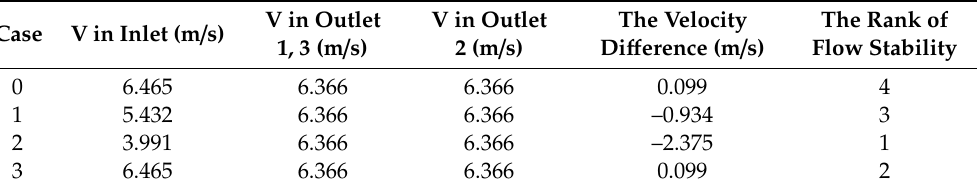
Table 5. The velocity in inlet and outlets in several